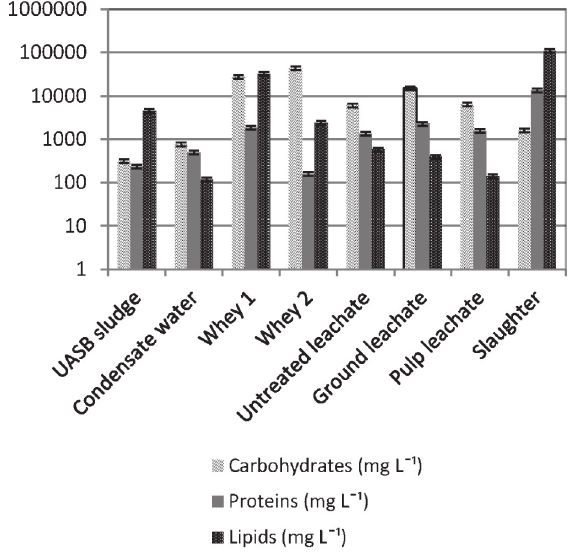
Fig. 1 – Results from macromolecular analysis of selected substrates, expressed as mean